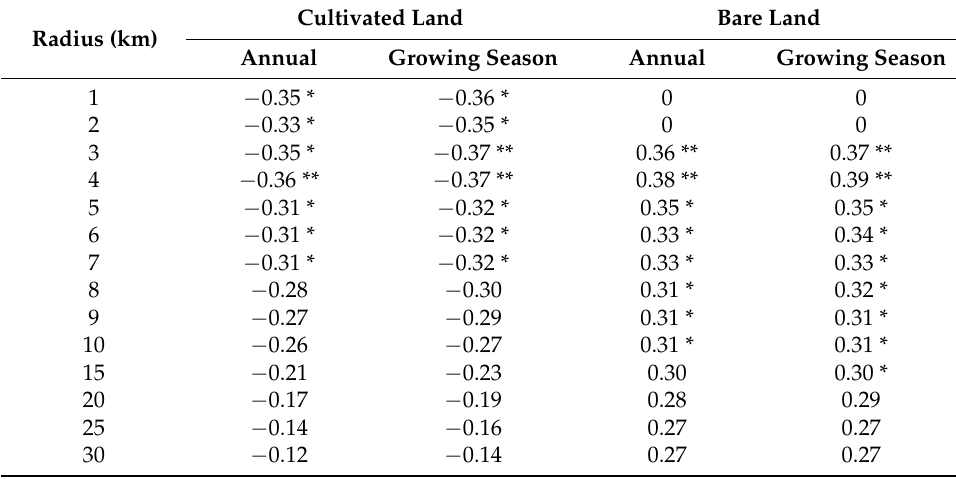
Table 1. The relationship between trends in ET0 and the different land use ratios with a certain radius centered around a